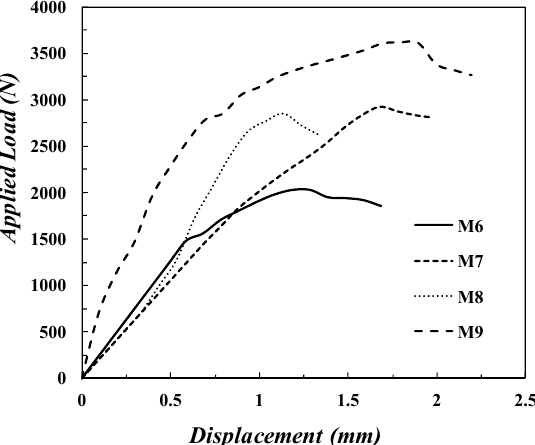
Figure 14. SPT Load–deflection curve for FGM composite samples with four layers varying in each layer glass fiber volume fraction.